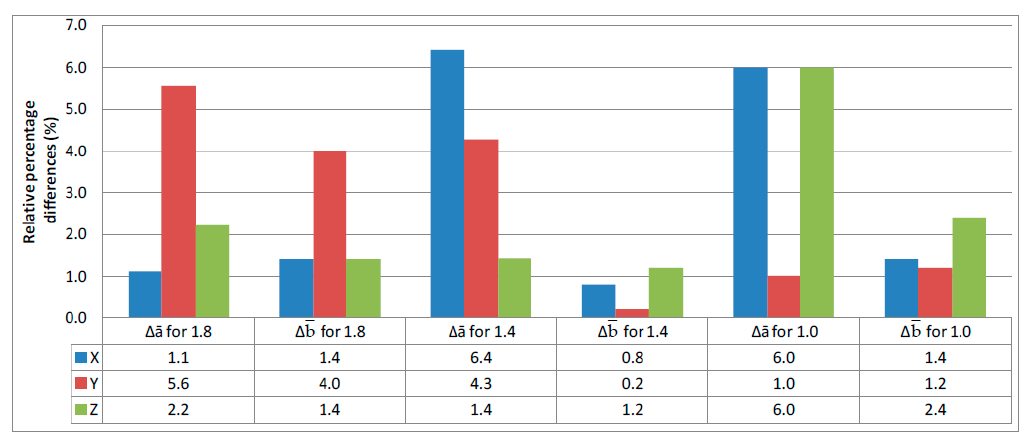
Figure 6. Relative percentage differences in sample thickness and width.